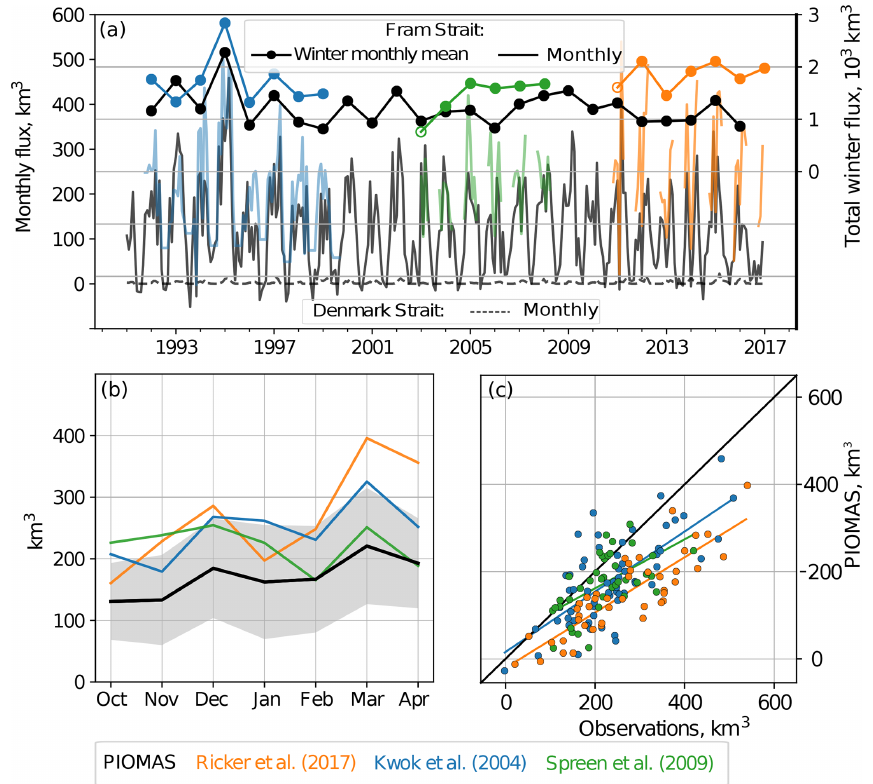
Figure 3. Sea ice volume fluxes (km 3 ): (a) time series of PIOMAS and observation-based monthly sea ice volume fluxes through Fram and the Denmark Straits, 1991–2016 (note that the total winter fluxes are referenced to the right y axis). Empty circles indicate seasons with an incomplete winter cycle. (b) Winter intra-annual cycle sea ice volume flux through Fram Strait, averaged over the period of the observations and over 1991–2016 for PIOMAS dataset. The gray background color corresponds to a single standard deviation interval from the PIOMAS mean. (c) Scatter diagram of monthly mean PIOMAS sea ice volume fluxes through Fram Strait versus monthly mean